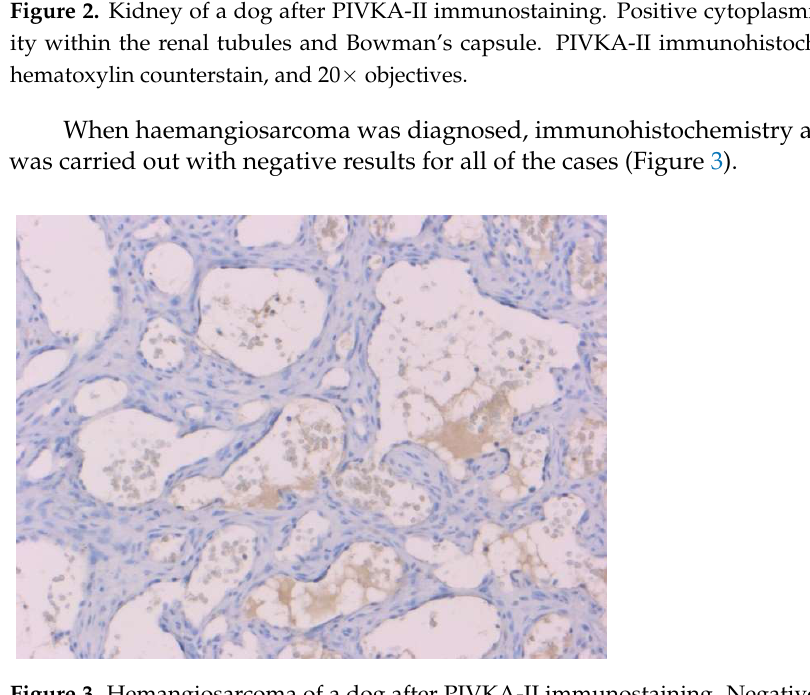
Figure 3. Hemangiosarcoma of a dog after PIVKA-II immunostaining. Negative in the neoplastic cells. PIVKA-II immunohistochemistry, Mayer’s hematoxylin counterstain, and 20× objectives.